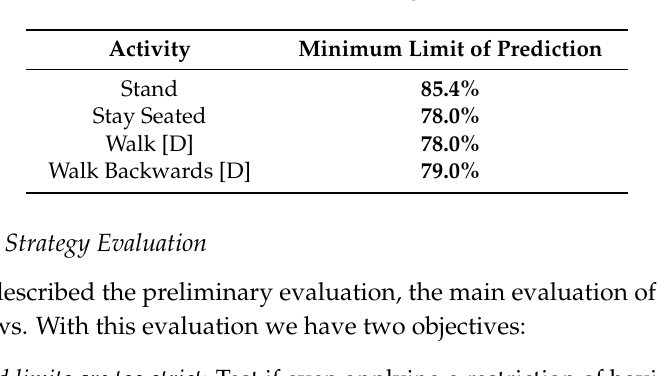
Table 1. Minimum Limits of Prediction assigned to the Sink Activities.